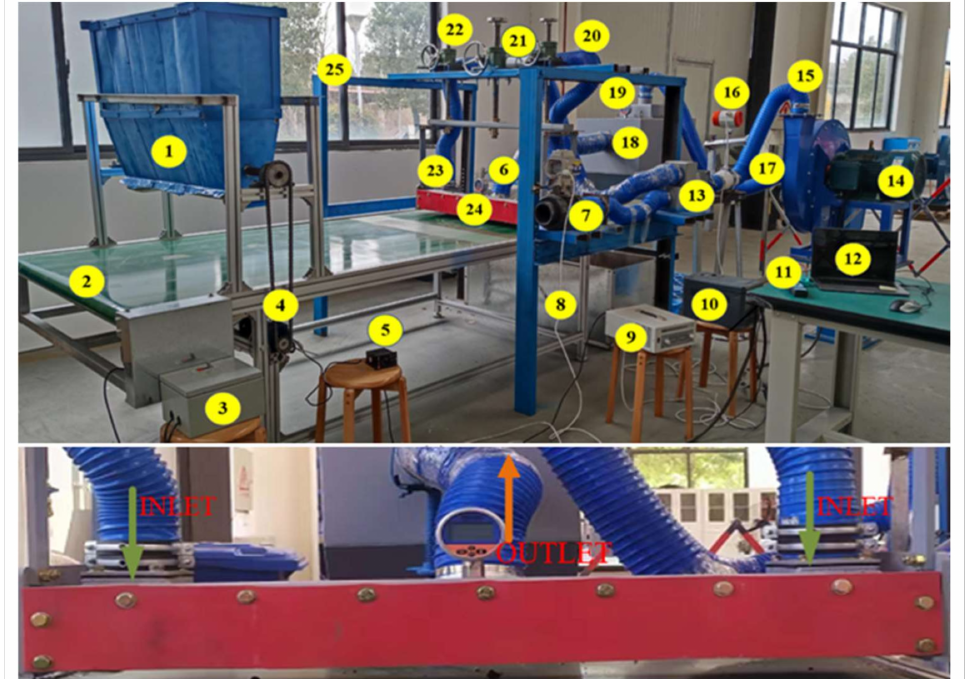
Figure 3. Experimental setup of regenerative air-vacuum sweeper. 1—Dust feeder;